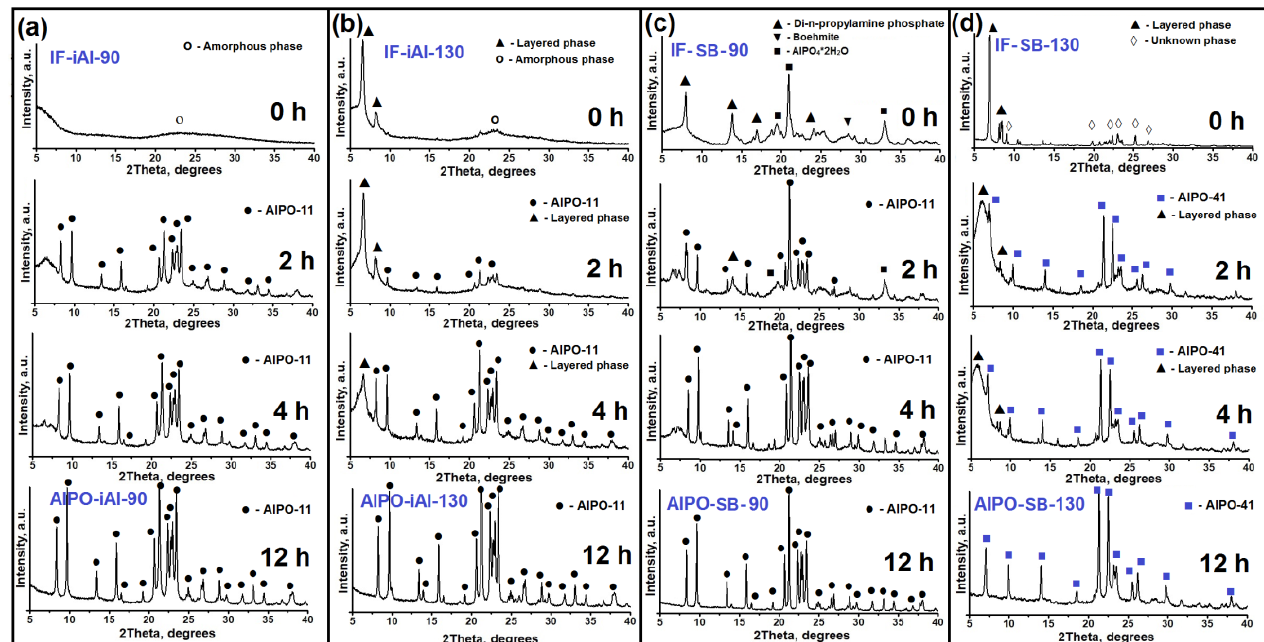
Figure 5. X-ray patterns of crystallization products of intermediate phases: (a) — Crystallization of the intermediate phase IF-iAl-90; (b) — Crystallization of the intermediate phase IF-iAl-130; (c) — Crystallization of the intermediate phase IF-SB-90; (d) — Crystallization of the intermediate phase IF-SB-90.